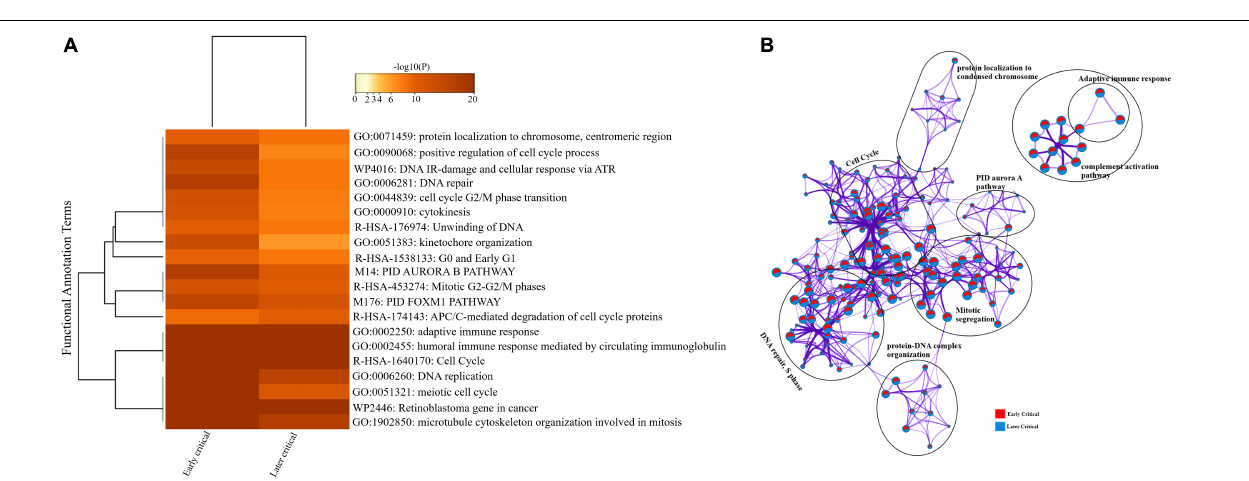
FIGURE 6 | Longitudinal analysis of early and later moderate stages of SARS-CoV-2 infected groups. (A) Heat map displaying the top 20 enrichment clusters for early and later disease onset of moderate COVID-19 groups colored by -log10(P) values using a discrete color scale representing statistical significance. The functional annotation terms and their corresponding categories are M (canonical pathways), GO (Gene Ontology), ko (KEGG ontology), WP (Wiki pathways), R-HSA (Reactome Gene Sets), and hsa (KEGG pathway). (B) Network visualization of the enriched clusters for the list of DEGs generated by Metascape. The clusters were labeled manually. The pie chart color code depicts the gene lists’ identities, where the red color represents early moderate patients, and the blue color represents later moderate patients.